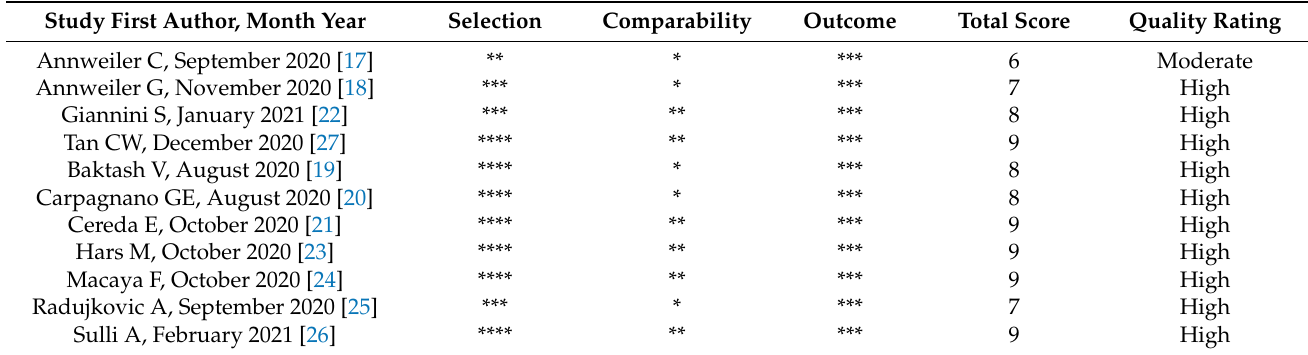
Table 5. Study quality assessment using Newcastle–Ottawa scale